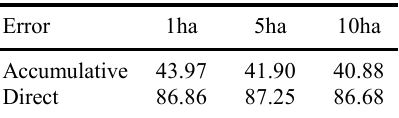
Table 6. Error between direct change and accumulative annual change maps between 2005 and 2010 for 1ha, 5ha and 10ha minimum mapping